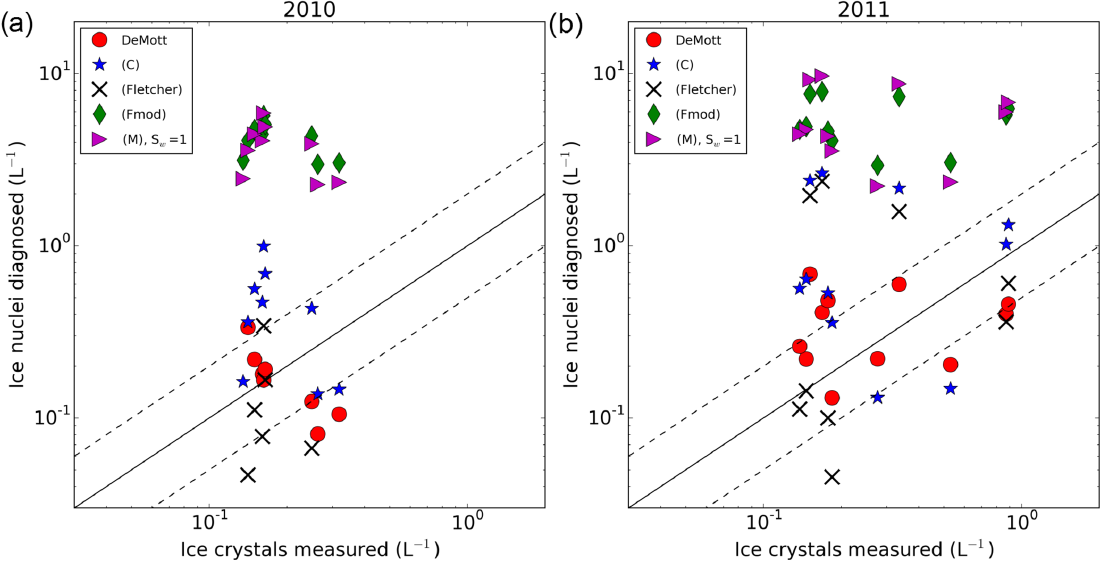
Figure 14. Predicted INP number densities versus observed number densities of crystals (flights averages) for various INP parameterizations for (a) 2010 and (b) 2011. The solid lines correspond to the one-to-one line, and the dashed lines corresponds to a factor-of-2 difference between the y and x axes. See Table 3 for the references of the various INP parameterizations.